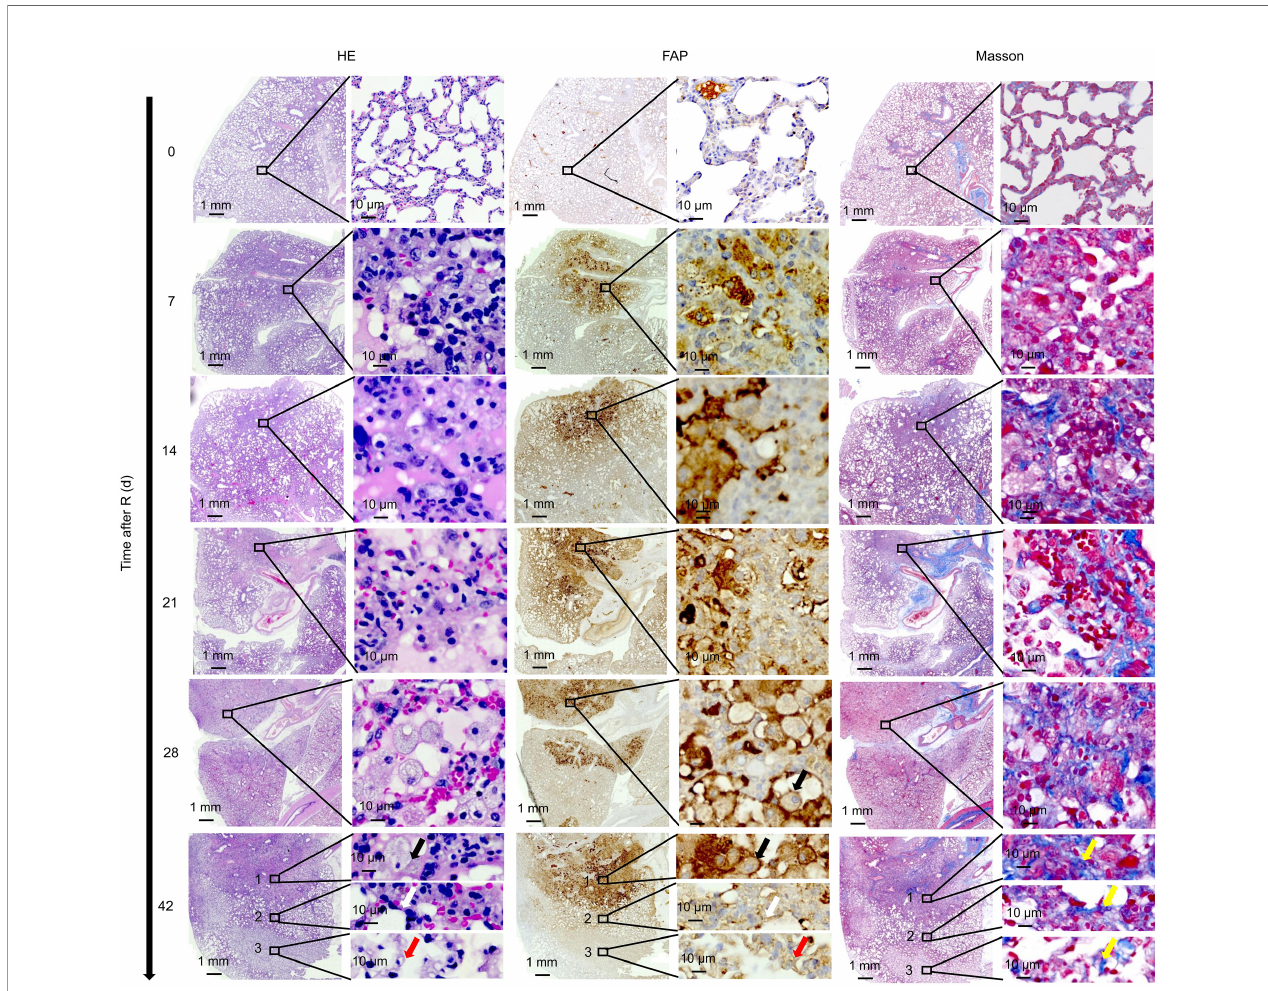
FIGURE 6 | Correlation between 18 F-NOTA-FAPI uptake and FAP expression. On day 7 after irradiation, foamy macrophages appeared in the damaged lung area, and large numbers offoamy macrophages and fi broblasts reappeared at day 28, remaining until day 42. IHC staining showed abundant FAP expression in the activated macrophages. Slight collagen deposition was detected on day 7, and the amount of collagen gradually increased thereafter based on Masson ’ s trichrome staining. On day 42 after radiation, in fi ltration of a large number of FAP+ macrophages were observed (black arrows) along with collagen deposition at the center of the irradiated area. At the border of the irradiated area, thickening of the alveolar walls and a decrease in alveolar air space was observed, leading to disappearance of the alveolar structure (white arrows). At the remote area distant from the irradiated lung tissue, a large number of FAP+ fi broblasts gathered. From the center of the irradiated area to the remote area distant from the irradiated lung tissue, the number of collagens gradually decreased (yellow